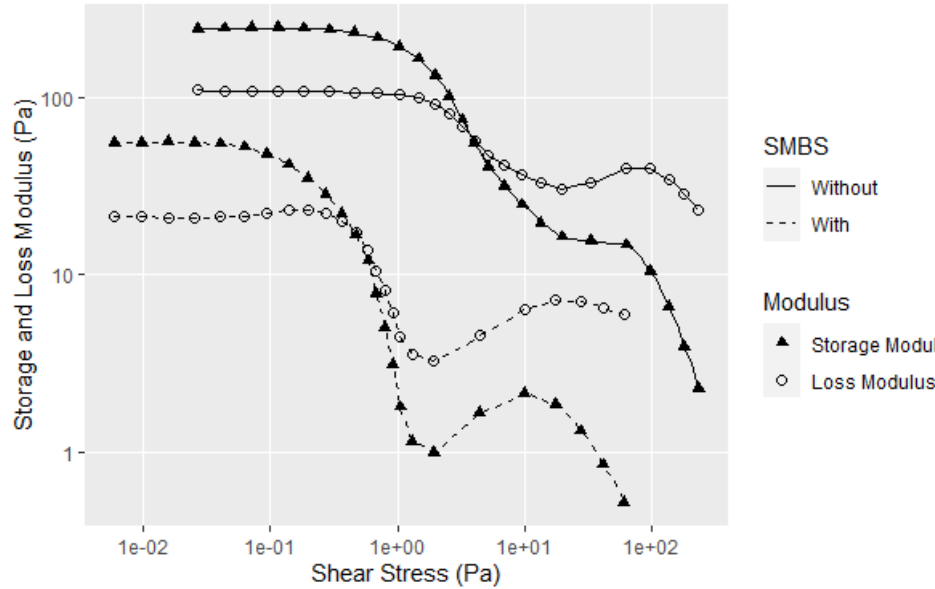
Figure 10. Amplitude sweep data for samples of 30% 90 PDI flour with 60 min of mixing, before and after the addition of SMBS. Single test shown (not average). All replicates shown in A9.